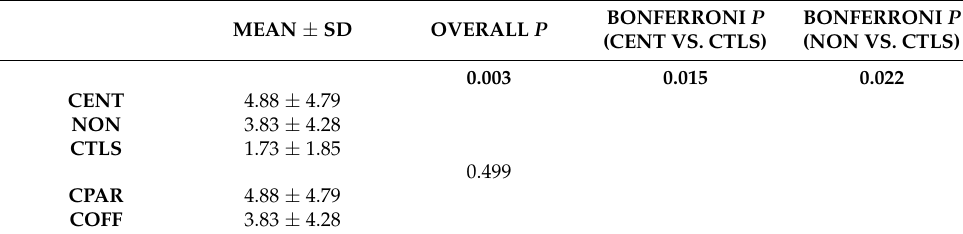
Table 3. Firmicutes/Bacteroidetes ratio analysis between CENT, NON and CTLs and between CPAR and COFF. MEAN ± SD OVERALL P